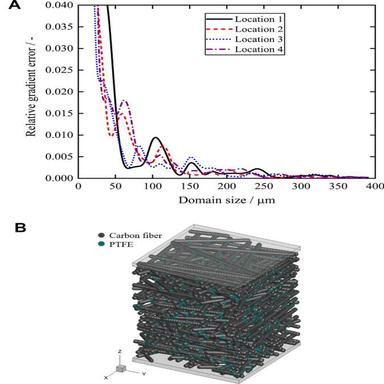
(a) Relative gradient errors for the porous composite transport media as a function of the window length and (b) the isometric view of a randomly generated porous transport layer.